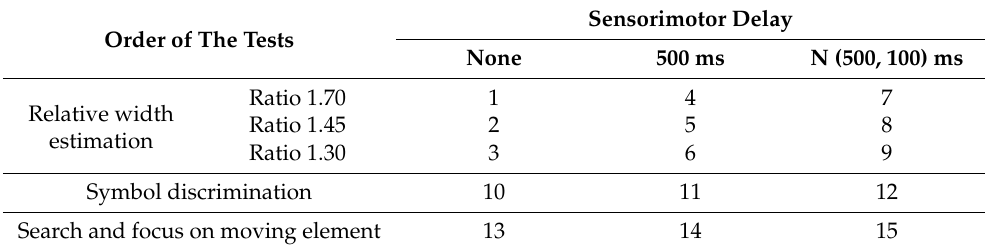
Table 1. Order of the